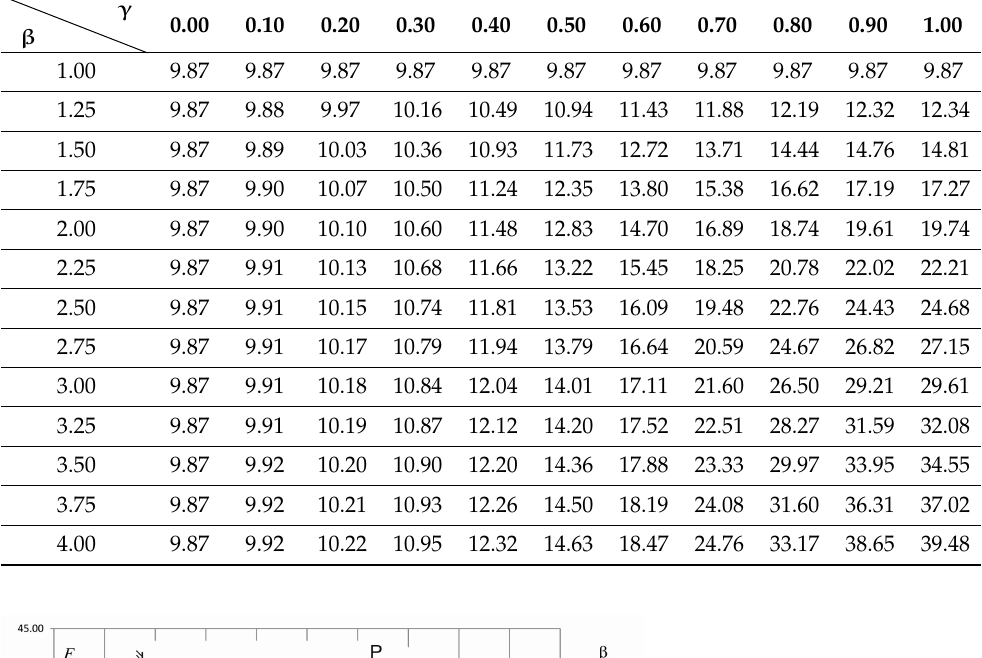
Table 1. Values F g /F d for different values β and γ .